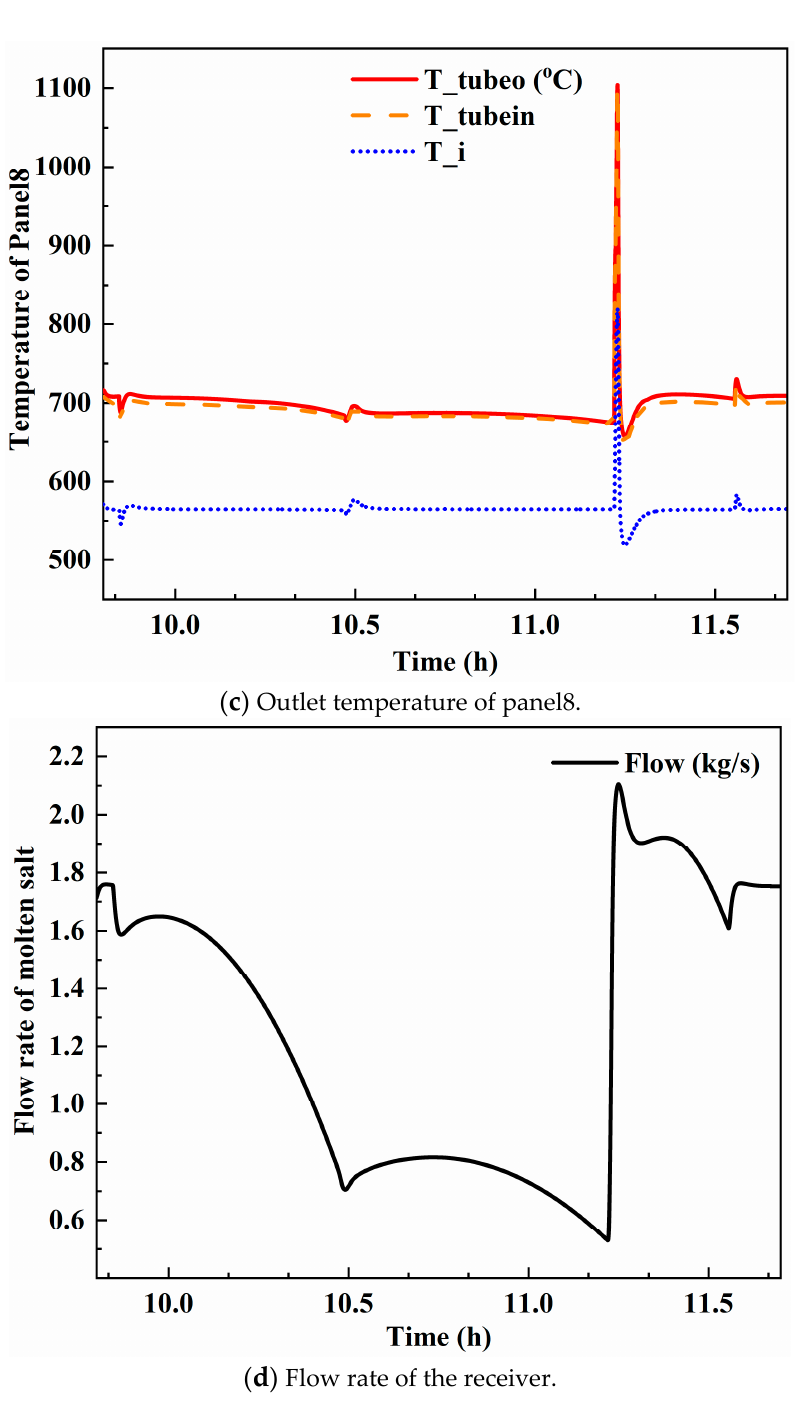
Figure 8. Response curves on a cloudy day under temperature control strategy.